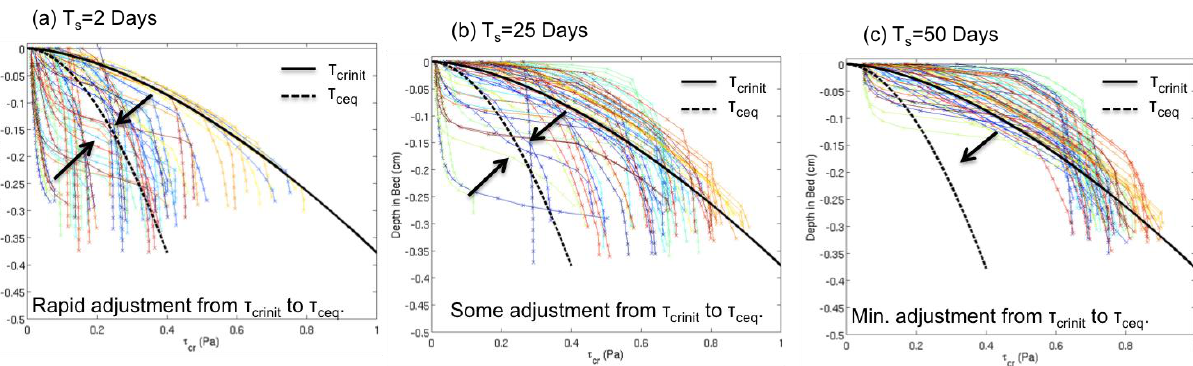
Figure 8. Daily instantaneous model calculated τ defined equilibrium ( τ defined as ( a ) 2 days, ( b ) 25 days, and ( c ) 50 days. Note: τ the directions that Equation (2) will nudge the instantaneous τ